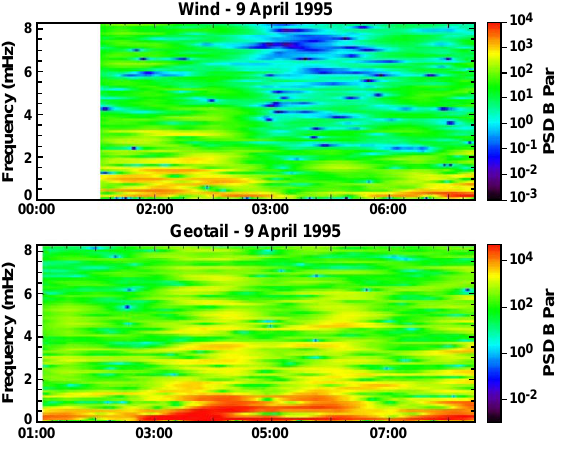
Fig. 14. Wind data in the solar wind in the central region of the high speed stream on 9 April 1995. Top panel: magnetic field and density; bottom three panels: field-aligned and perpendicular com- ponents of b and v .